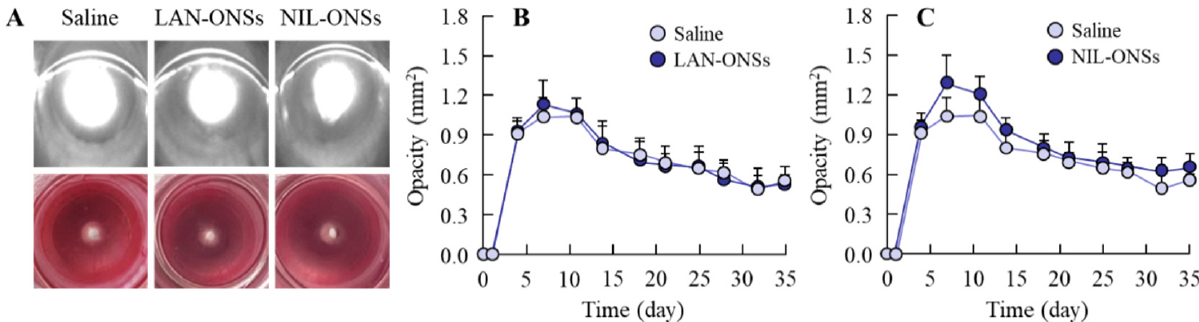
Figure 4. Effect of ophthalmic formulations on opacification in the sodium-selenite-induced cataractic rats. ( A ): digital and Scheimpflug slit images of the sodium-selenite-induced cataractic rats repeatedly instilled with LAN-ONSs and NIL-ONSs. The images were measured at 35 days after the injection of sodium selenite. B and C: changes in opacity levels in the sodium-selenite-induced cataractic rats repeatedly instilled with LAN-ONSs ( B ) and NIL-ONSs ( C ). Twenty microliters of ophthalmic formulations (0.5% LAN or 0.6% NIL), shown in Table 1, were instilled one time/day for 28 days. The start day and the end day of dosing were 7 and 35 days after injection of sodium selenite, respectively. Saline, sodium-selenite-induced cataractic rat repeatedly instilled with saline; LAN- or NIL-ONSs, sodium-selenite-induced cataractic rat repeatedly instilled with LAN-ONSs or NIL-ONSs ( n = 7–12). The opacity levels were similar between sodium-selenite-induced cataractic rats repeatedly instilled with or without LAN-ONSs and NIL-ONSs.